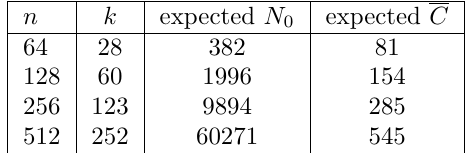
Table 1: Parameter estimation of the ISD-based algorithm for some value of n and k